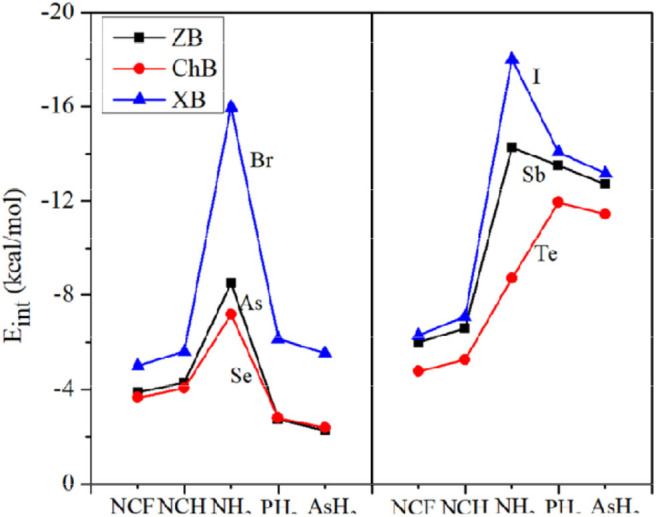
Plots of the interaction energy (Eint) for different bases.